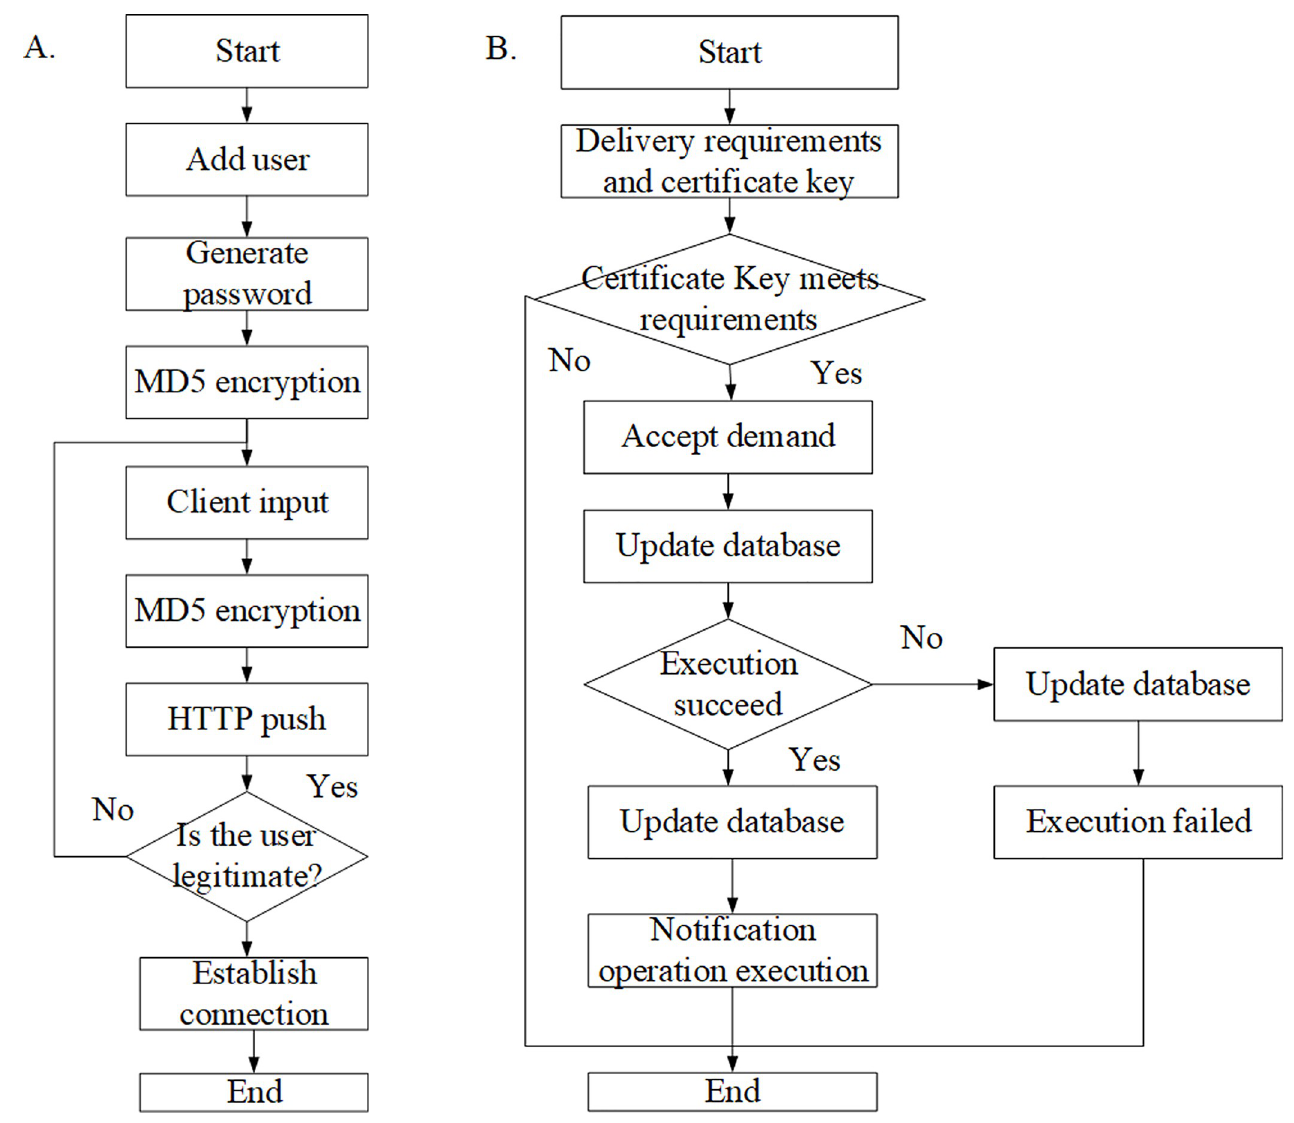
Fig 9. Connection between server and